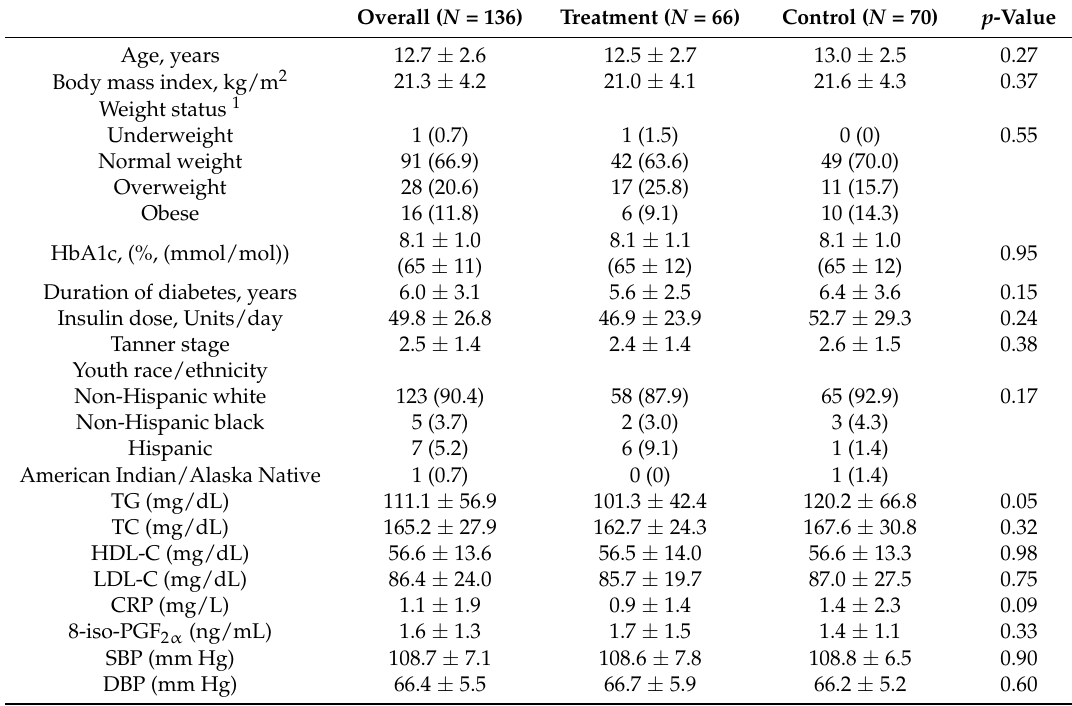
Table 1. Baseline demographic characteristics of youth with type 1 diabetes overall and by treatment assignment.